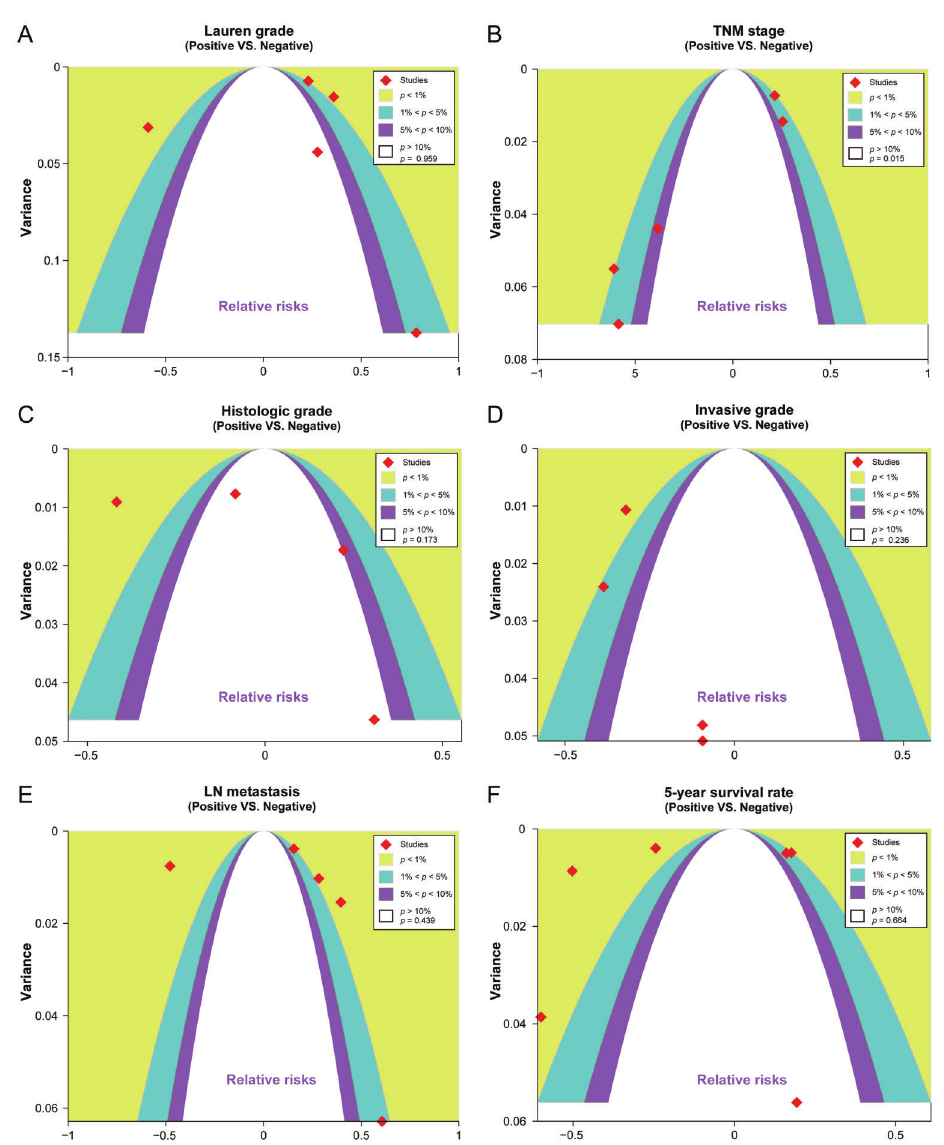
Figure 5. Publication bias of the correlation between cadherin-17 (CDH17) protein expression and the prognosis of patients with gastric cancer (GC).